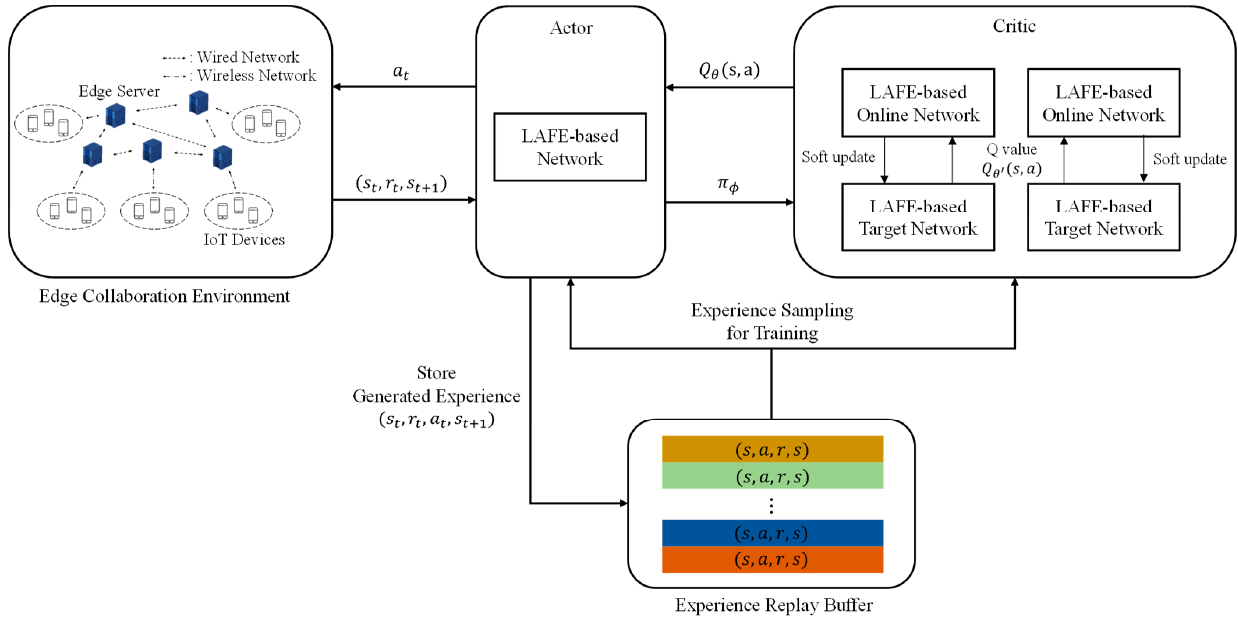
Figure 2. The proposed DDPG structure.